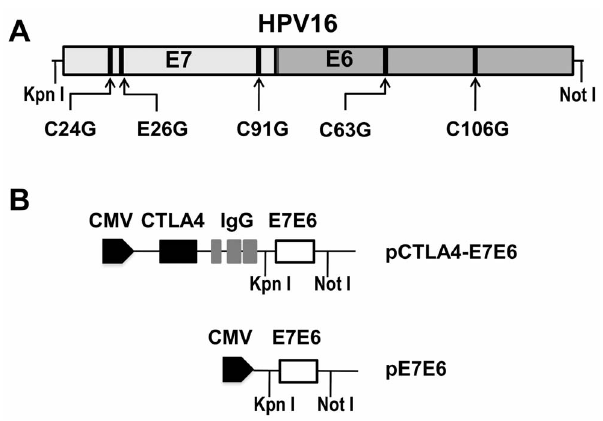
Figure 1. Construction of DNA vaccines pCTLA4-E7E6 and pE7E6. HPV16 E7 gene was fused with E6 gene. The fusion gene was optimized with human biased codons. ( A ) Mutation introduced into HPV16 E7 and E6 to disrupt transformation activity are labeled in the schema. 24 C, 26 E and 91 C of E7 and 63 C and 106 C of E6 (arrows) were mutated to glycine. ( B ) pE7E6 was constructed by cloning the modified E7E6 fusion gene into pVAX1 vector at Kpn I and Not I restriction sites. pCTLA4-E7E6 encodes the signal peptide and extracellular domains